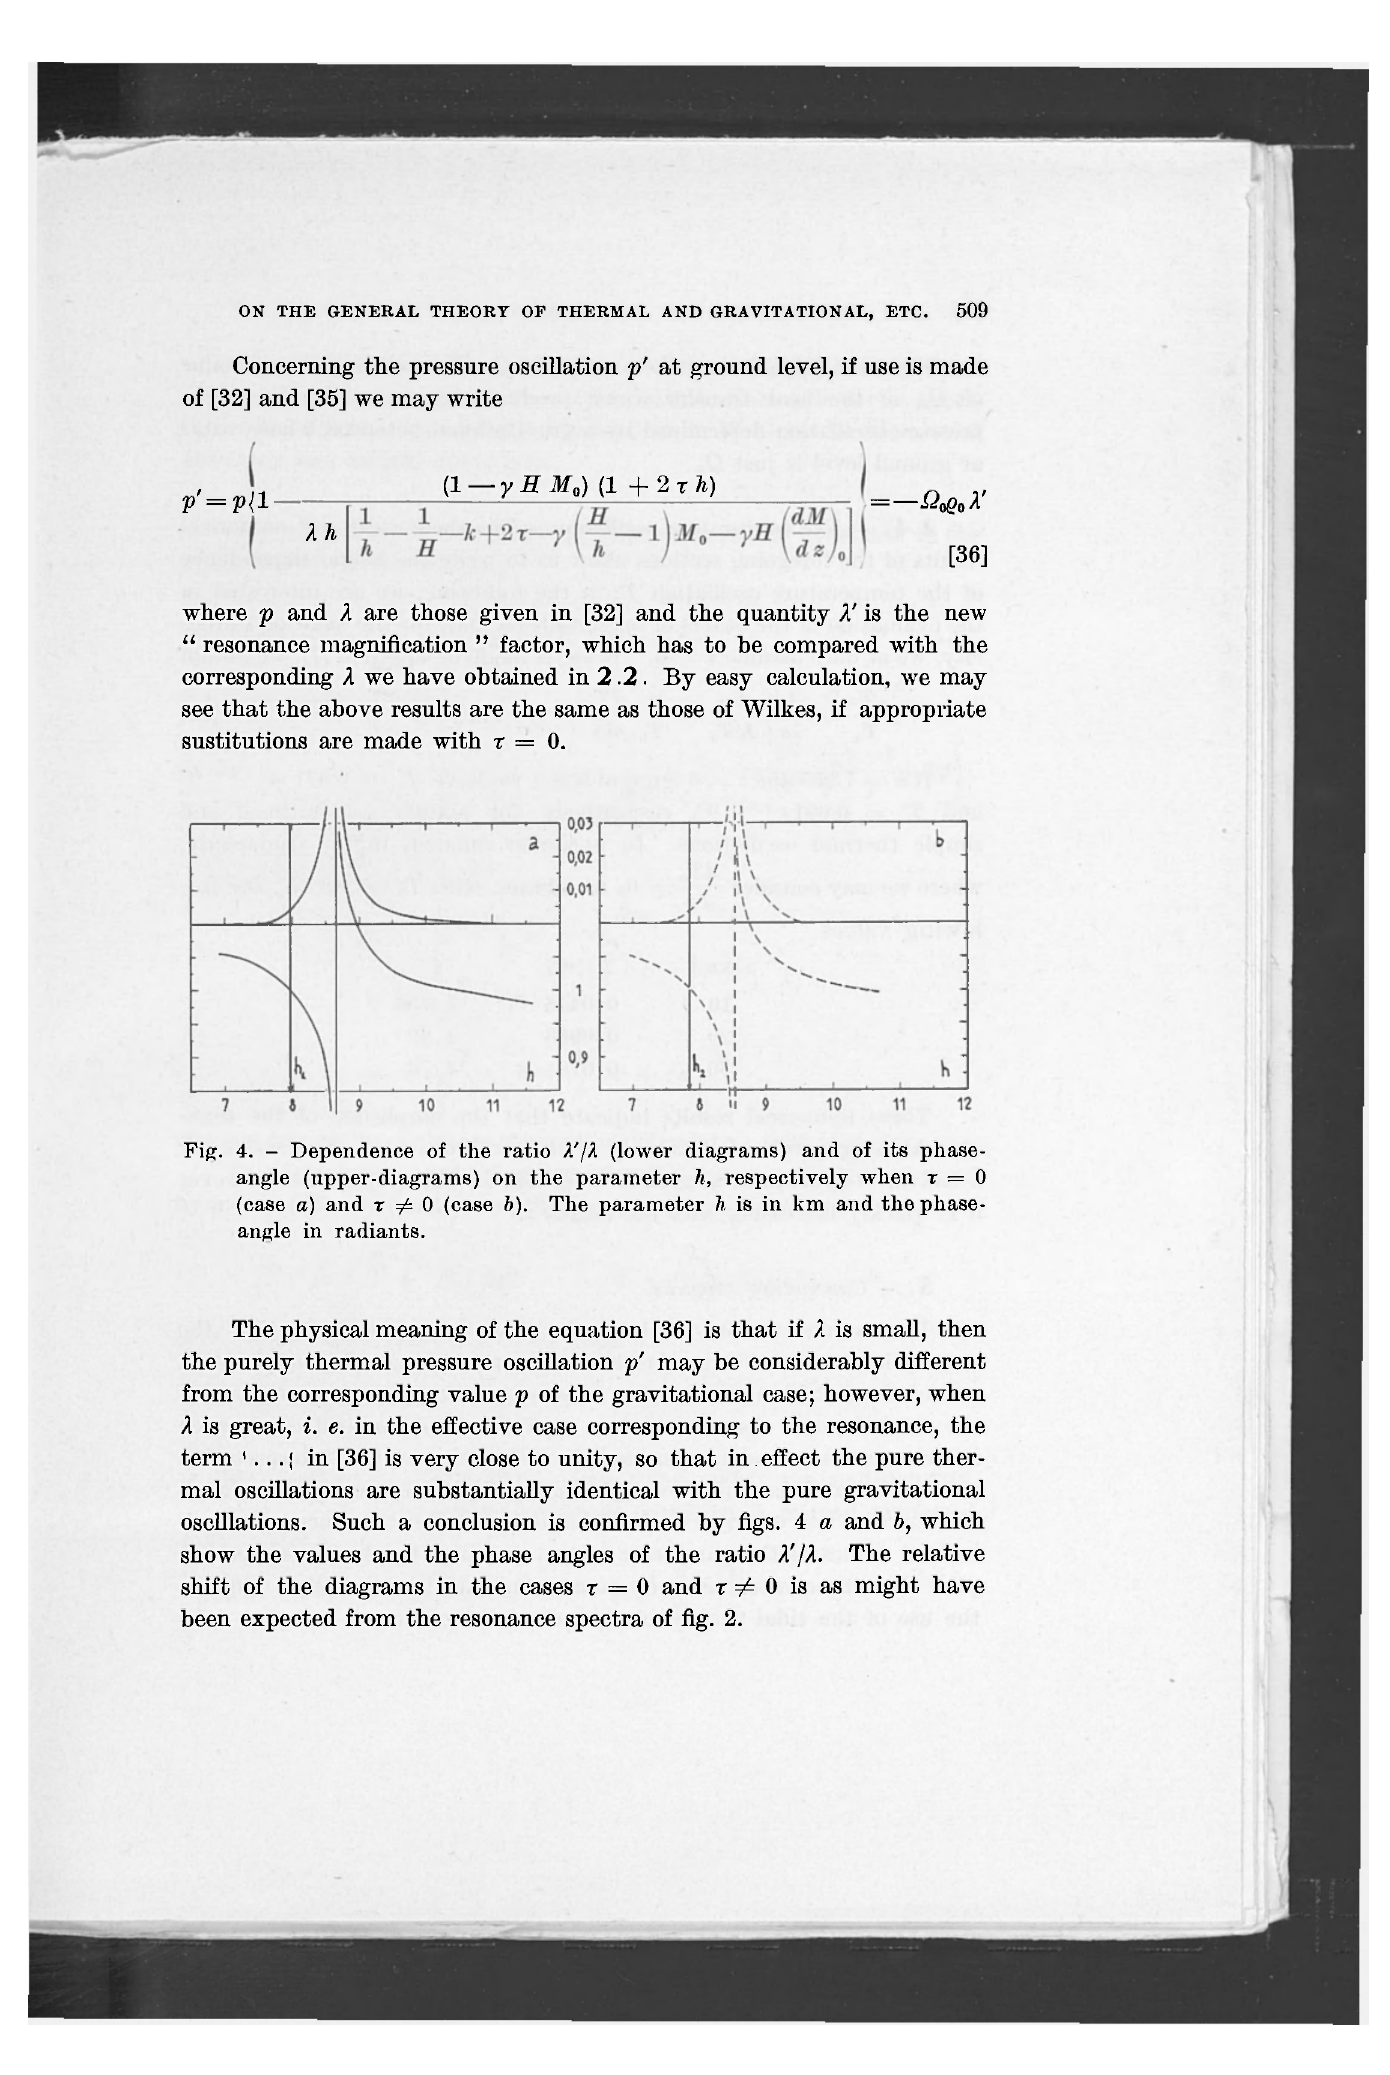
Fig. 4. - Dependence of the ratio A'/A (lower diagrams) and of its phase- angle (upper-diagrams) on the parameter li, respectively when r = 0 (case a) and r # 0 (case b). The parameter h is in km and the phase- angle in